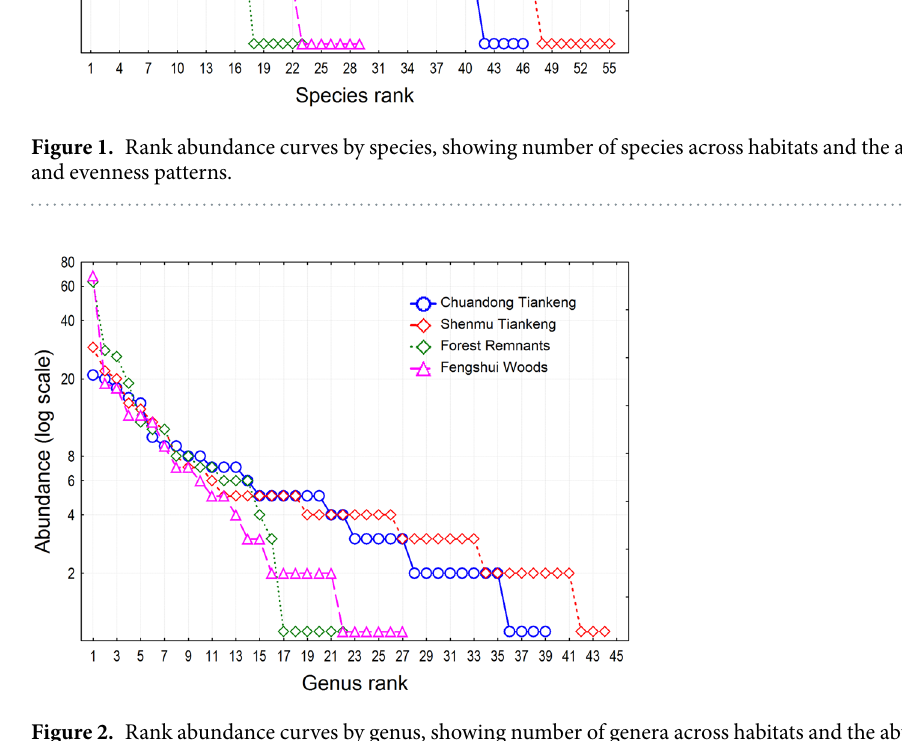
Figure 2. Rank abundance curves by genus, showing number of genera across habitats and the abundance and evenness